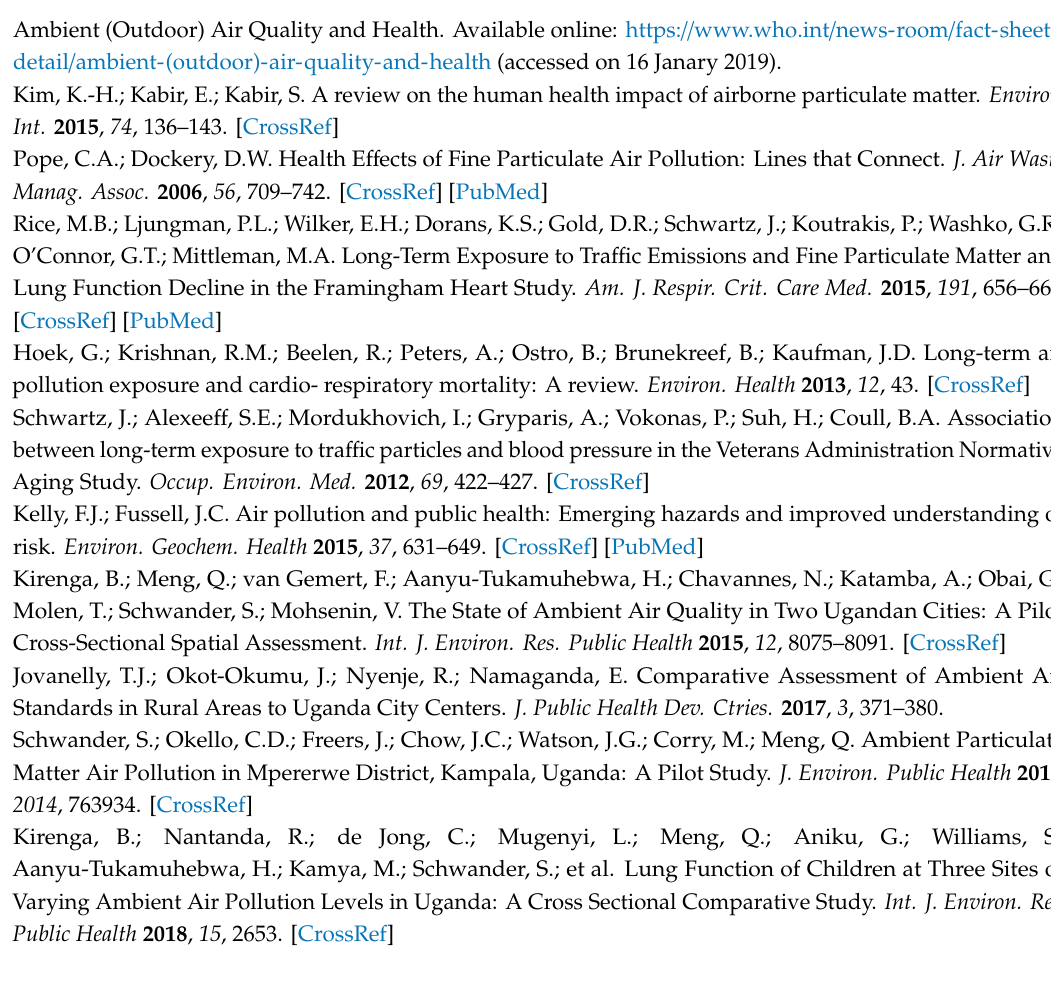
Table S1: Summary of data collection. The sampling locations are described in Section 2 of the paper. Each data collection period was 24 hours, starting at the date and time shown. Gravimetric samples were collected on filters in the PEM, while optical data were collected by the SidePak. Seasons were generally consistent with the expected dates (dry = December–January and June–August; wet = February–May and September–November), but some samples near the transitions were re-assigned based on observed rainfall. Weekends are Saturdays and Sundays. For sampling times that overlap weekdays and weekends, such as those starting in the late afternoon on a Friday or Sunday, the assignment was made based on the majority of the sampling time. Missing data are left blank, Table S2: Summary of the one sample t-test for the 24-h means in the three sampling locations. The annual air quality guideline and interim target values were used as standard means, Table S3: Summary of the independent sample t-test comparing seasonal and day of week di ff erences. The means for each data set are shown along with the standard deviation of the mean. t -( p -) values are the values of statistical test parameters t - value and p -value